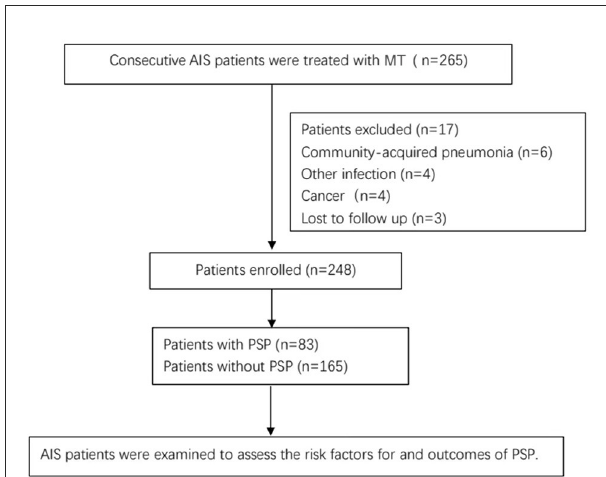
FIGURE1 Enrollment flow diagram. AIS, acute ischemic stroke; MT, mechanical